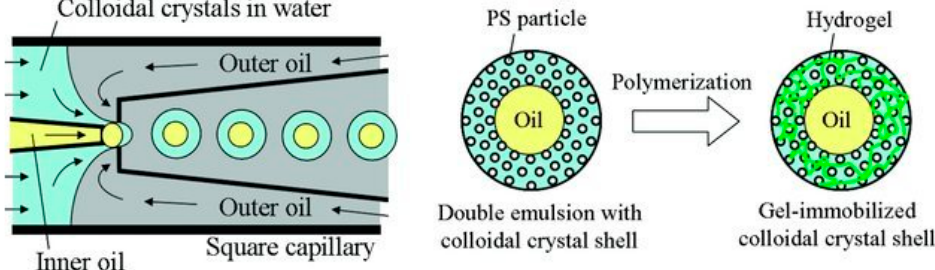
Figure 7. Fabrication of microcapsules with gel-immobilized colloidal crystal shells using capillary microfluidics and photopolymerization. Reprinted with permission from [27].